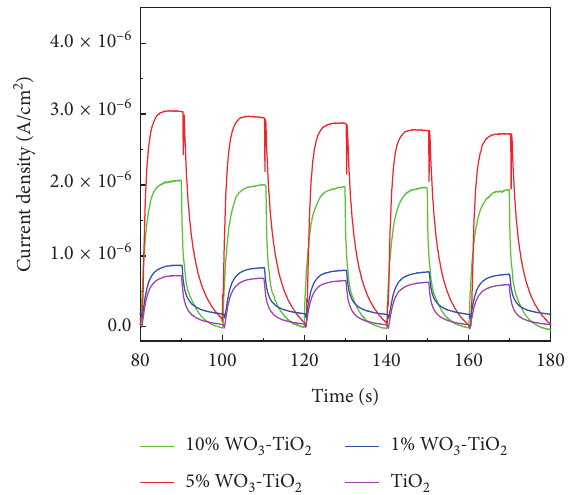
Figure 4: Photocurrent response curves of TiO